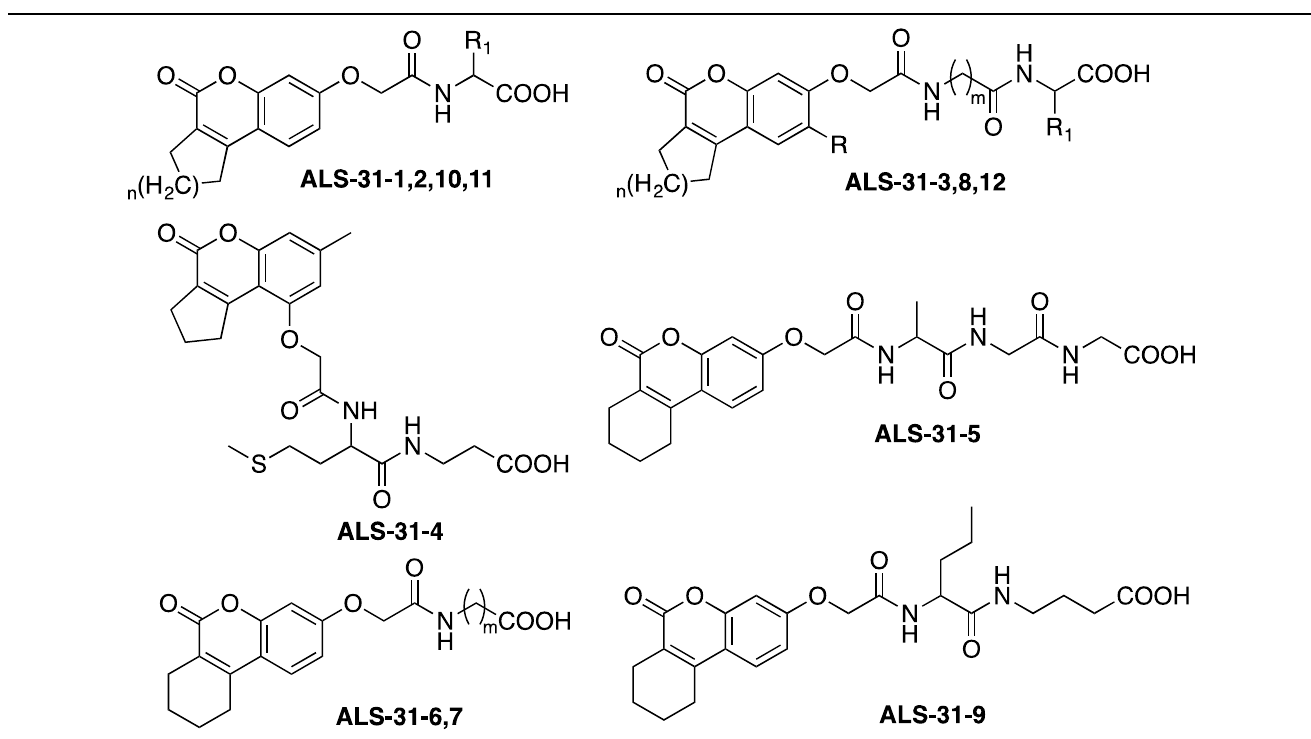
Table 2. Structure of ALS-31 derivatives and their effect on Sm SOD activity.